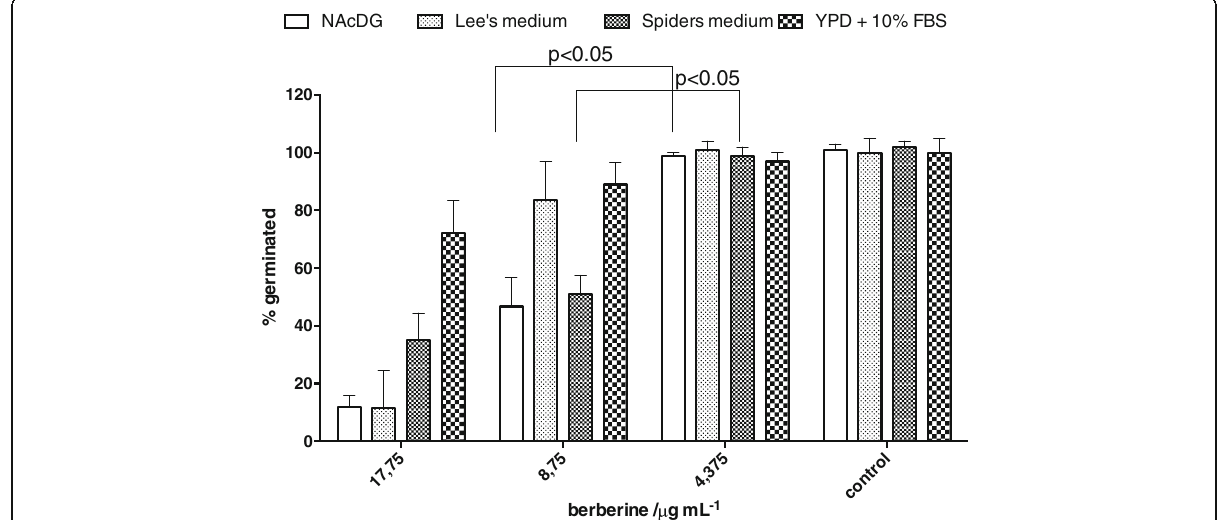
Fig. 3 Effect of different concentrations of berberine on germ tube formation in C. albicans ; NC – intact cells. The data are shown as means ±